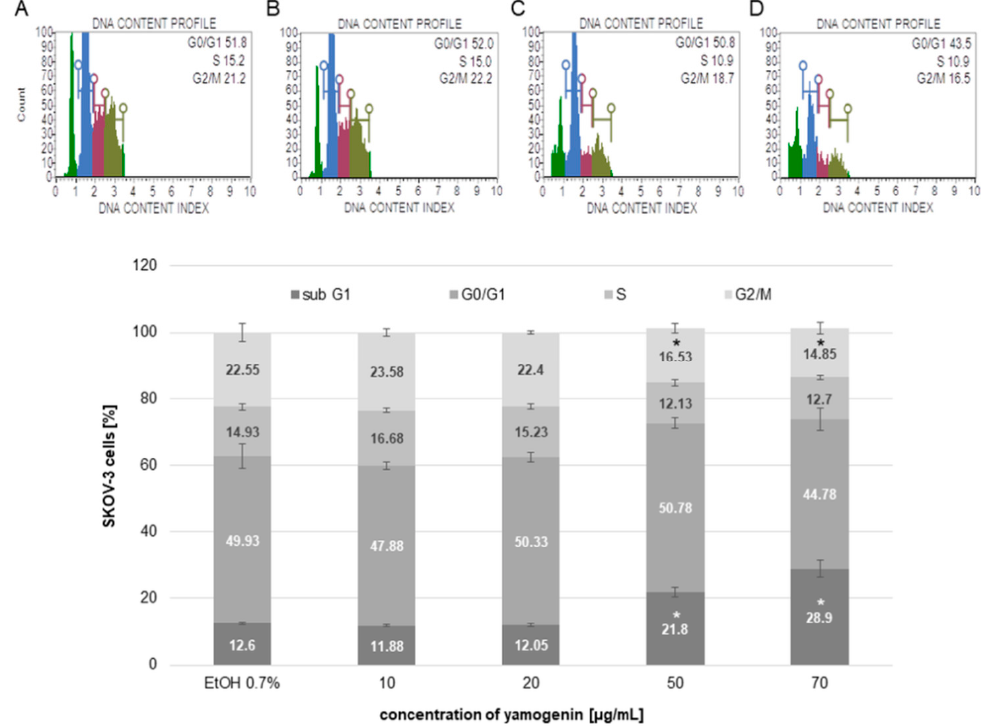
Figure 5. The arresting of SKOV-3 cell cycle induced by yamogenin. The ethanol and compound were added to the cells at concentrations of 0.7% (( v / v ), a control, ( A )) and 10, 20 ( B ), 50 ( C ), and 70 µg/mL ( D ), respectively. After 48 h, the cells were analyzed with flow cytometry. Green color on ( A – D ) represents the sub-G1, blue—the G0/G1, purple—the S, and khaki—the G2/M population of the cells. The values represent the means ± SD obtained from three independent experiments. Error bars represent standard deviations. Significant differences relative to the control are marked with an asterisk (the Student’s t -test, * p < 0.05).